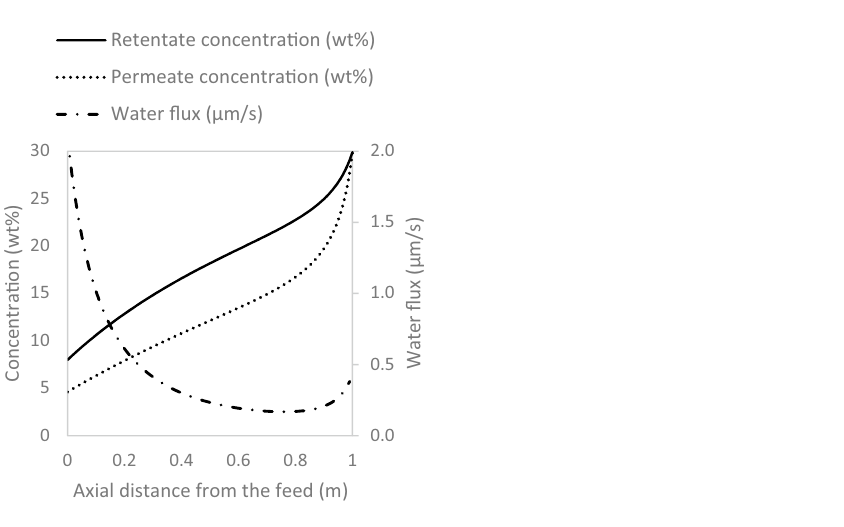
Figure 6. Concentration and flux profiles along the length of the modules, for OARO, corresponding to the basis of case study laid out in Table 5 — feed at 8 wt%.